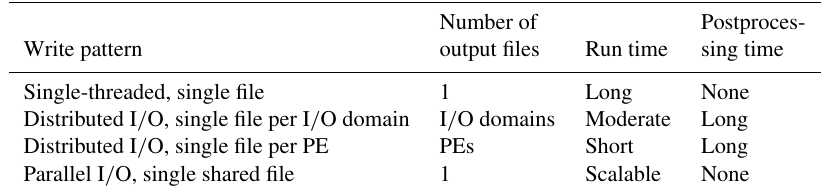
Table 1. Comparison of write pattern between serial I / O and parallel I / O. Number of Postproces- Write pattern output files Run time sing time Single-threaded, single file 1 Long None Distributed I / O, single file per I / O domain I / O domains Moderate Long Distributed I / O, single file per PE PEs Short Long Parallel I / O, single shared file 1 Scalable